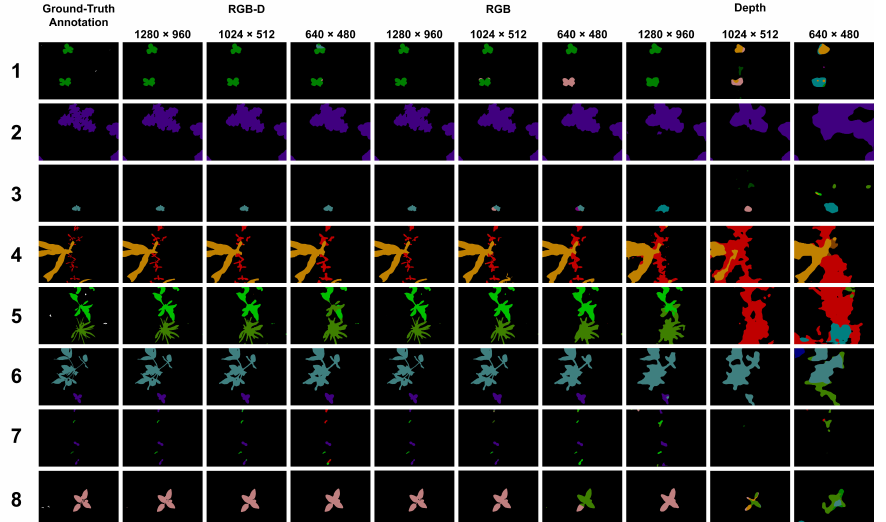
Figure 7. Comparison of semantic segmentation results for different input scales and modalities. From left to right: ground-truth annotation, full-scale (1280 × 960 pixels) RGB-D, medium-scale (1024 × 512 pixels) RGB-D, low-scale RGB-D (640 × 480 pixels), full-scale RGB, medium-scale RGB, low-scale RGB, full-scale depth, medium-scale depth, low-scale depth. Rows (from top to bottom) show images taken in broad bean (1), milk thistle (2), soybean (3), combined corn and cornflower (4), combined sugar beet and corn cockle (5), combined soybean and milk thistle (6), combined sugar beet and milk thistle (7), and sunflower (8). Color codes of the segmentation masks (ground-truth and prediction) correspond to those given in Figure 4, white pixels belong to a void class that was ignored in training and